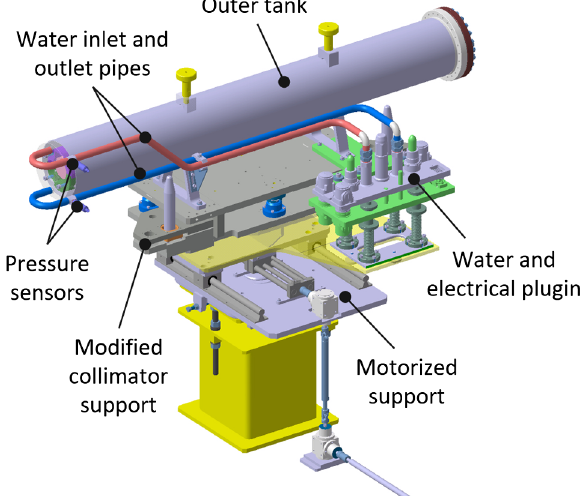
FIG. 5. Overview of the BDF target prototype assembly: the outer tank, the modified collimator support, the motorized support and the remote plug-in system are